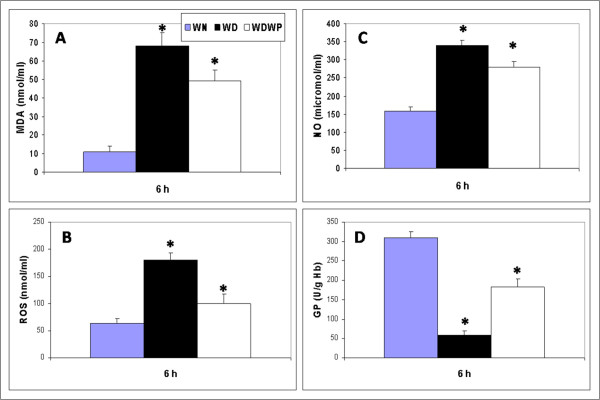
Oxidative stress in non-diabetic normal rats (WN), diabetic rats (WD) and diabetic rats supplemented whey protein (WDWP). MDA, NO and total glutathione were measured in liver tissues, while ROS was estimated in skin tissue. All oxidative markers were significantly elevated in the diabetic rats. Whey protein restored the levels of these markers in WDWP rats to levels close to those of the control rats and significantly increased glutathione levels.